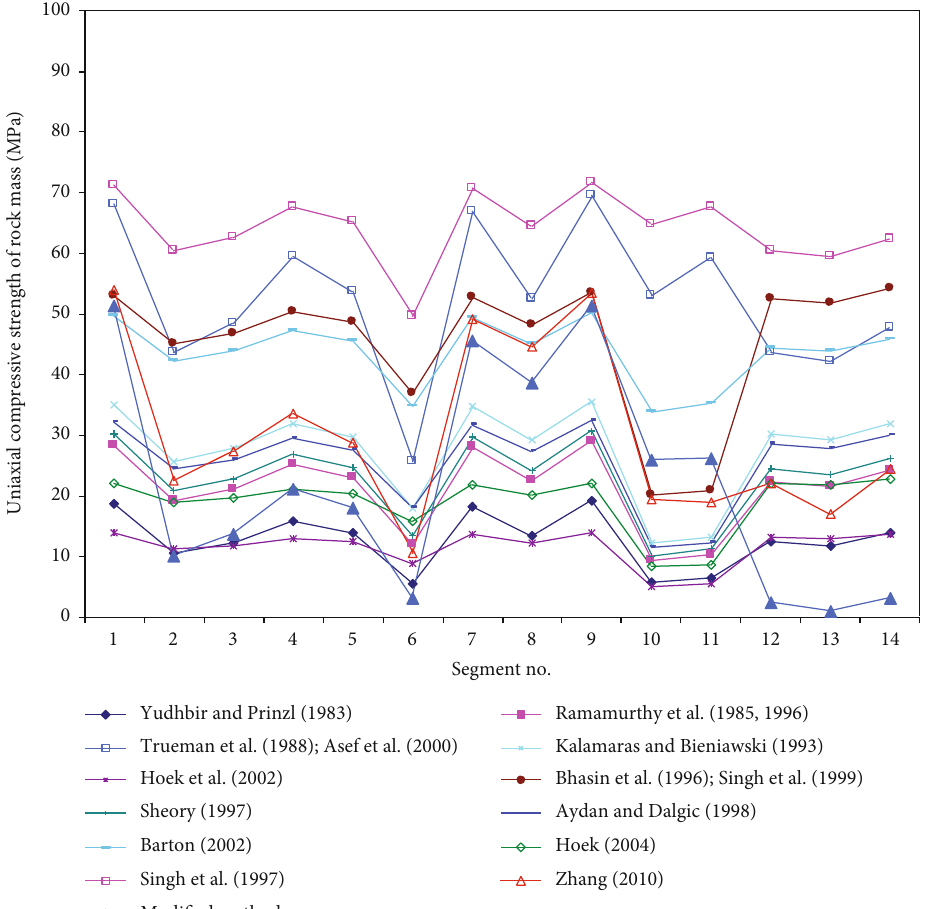
Figure 6: A comparative study of the developed relation with the estimated strength values from the previous empirical